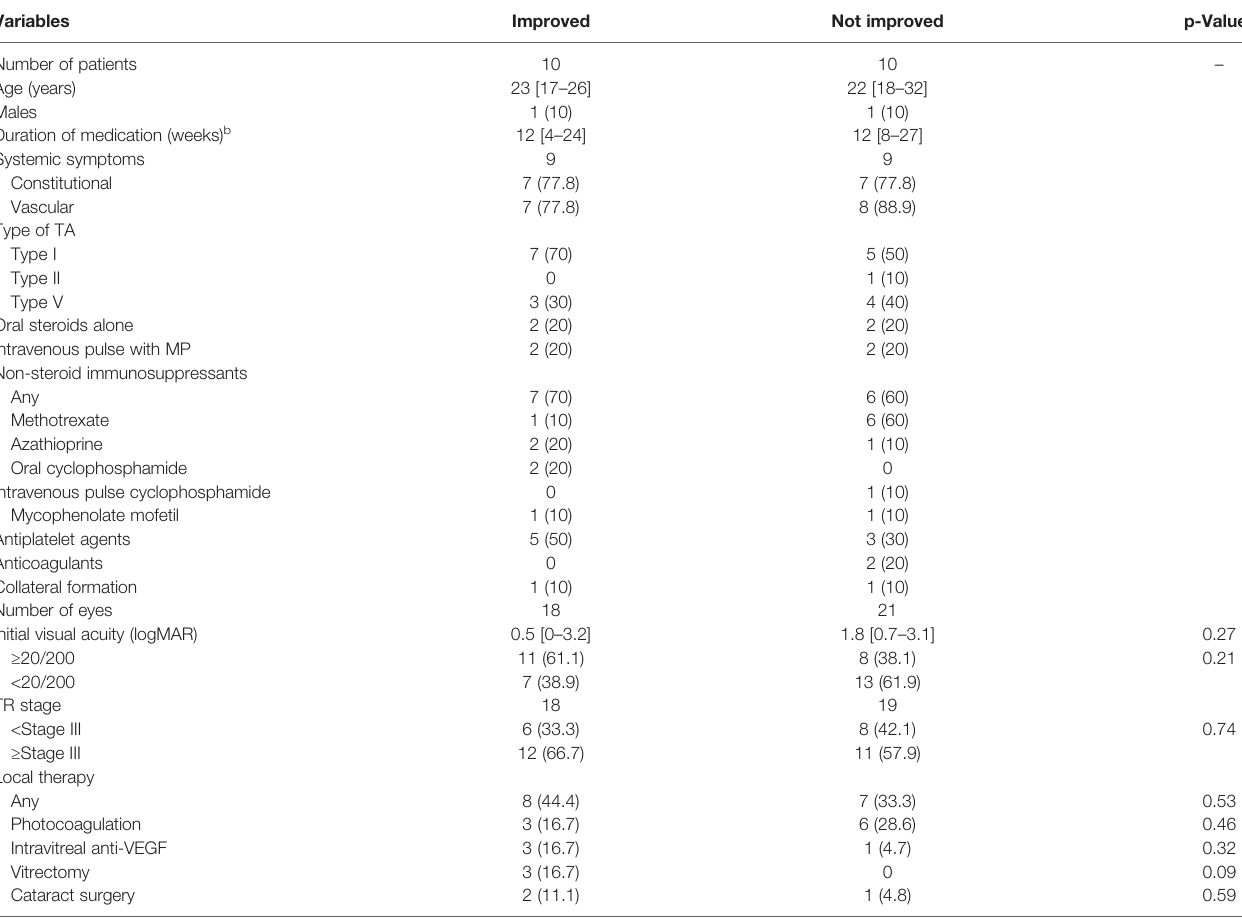
TABLE 2 | Comparison of TR patients with and without ocular improvement after medical therapy